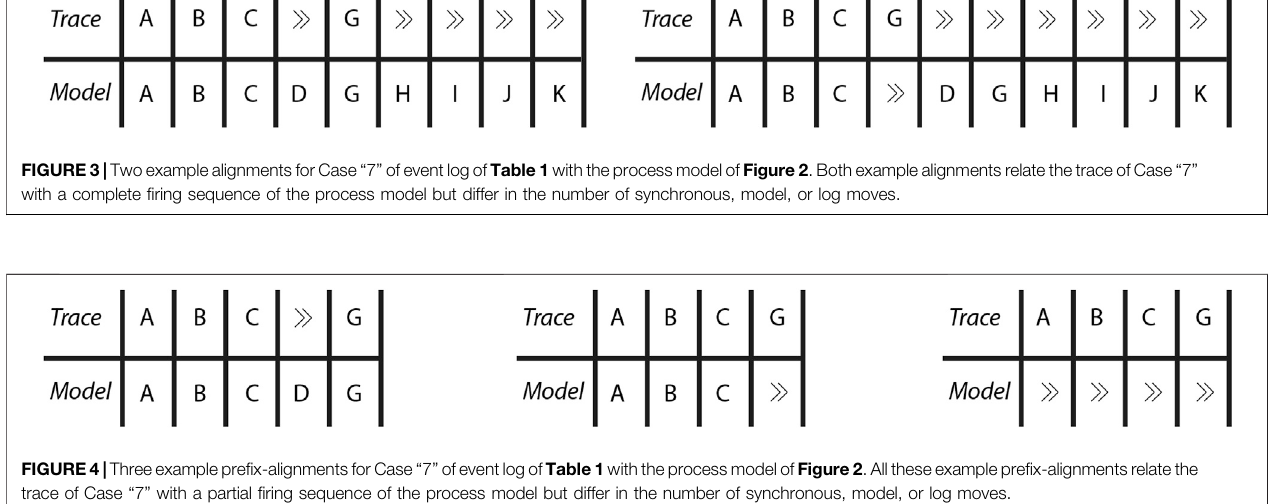
Frontiers in Big Data |